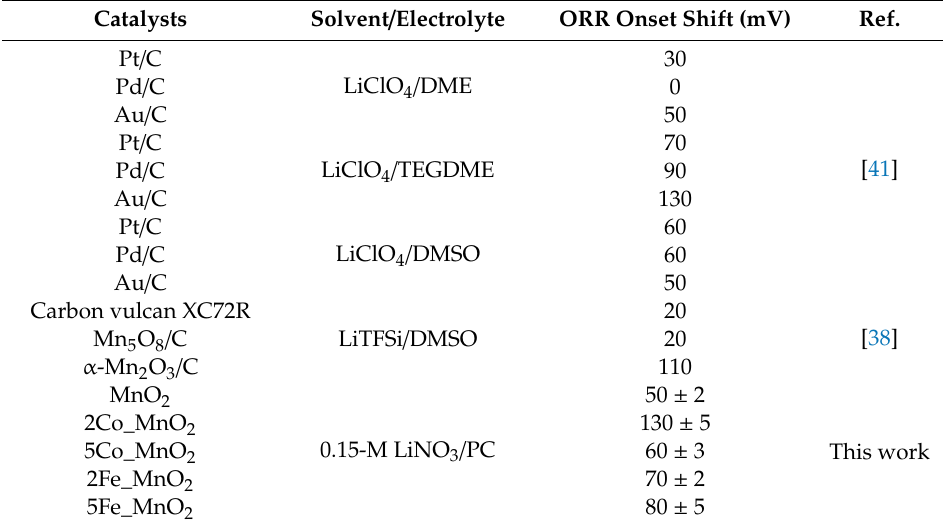
Table 1. Comparison of oxygen reduction reaction (ORR) onset potential shifts obtained using di ff erent electrocatalysts deposited on GCE, from either literature or this work. For the latter, standard deviations computed on at least 3 measurements are reported. Onset potentials shifts were computed considering bare GCE as benchmark. GCE onset = 2.59 V vs. Li / Li + . Catalysts Solvent / Electrolyte ORR Onset Shift (mV) Ref. Pt / C LiClO 4 / DME